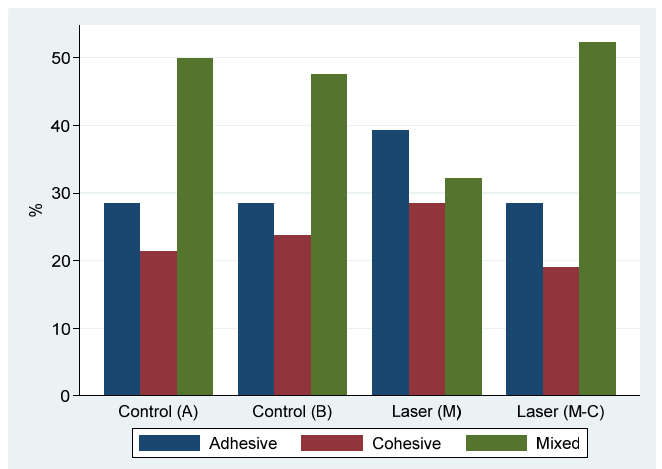
Figure 7. Failure types.